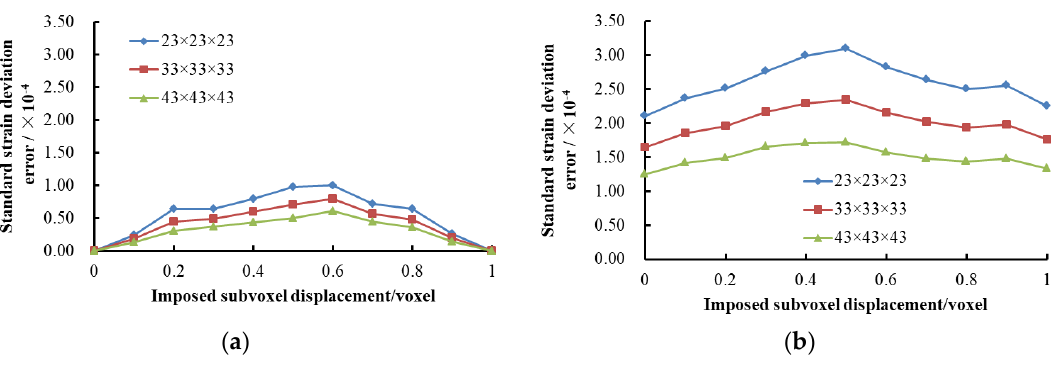
Figure 15. The standard deviation error of strain with different sizes of the strain calculation cubic box ( a ) Group 1; ( b ) Group 2.